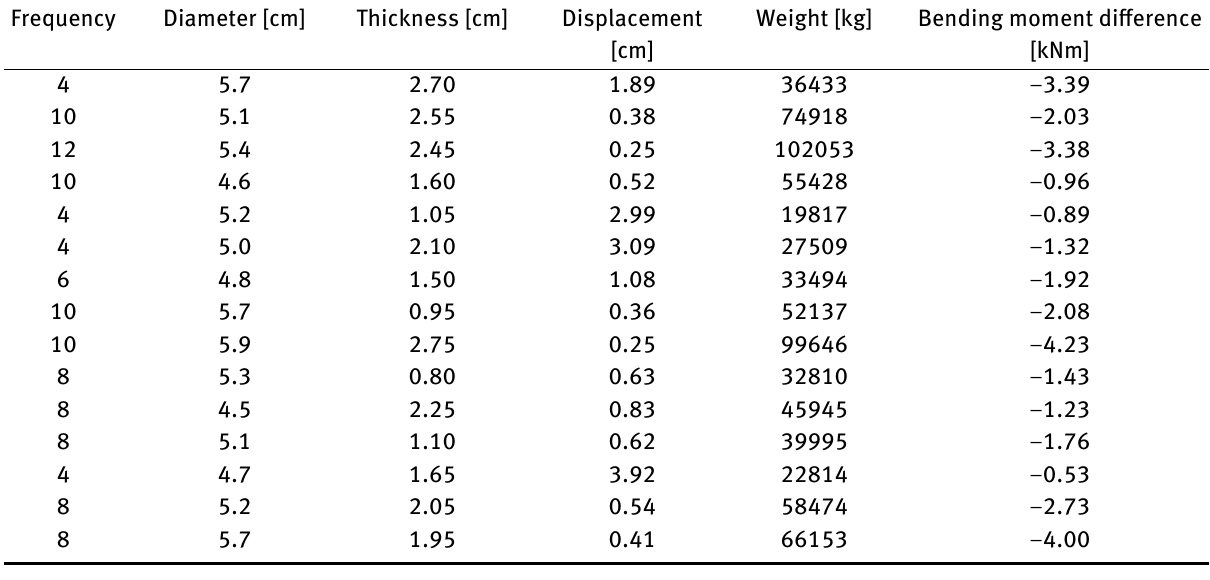
Table 4: Input and output values obtained through the process of optimization (part of the data from the attachment)